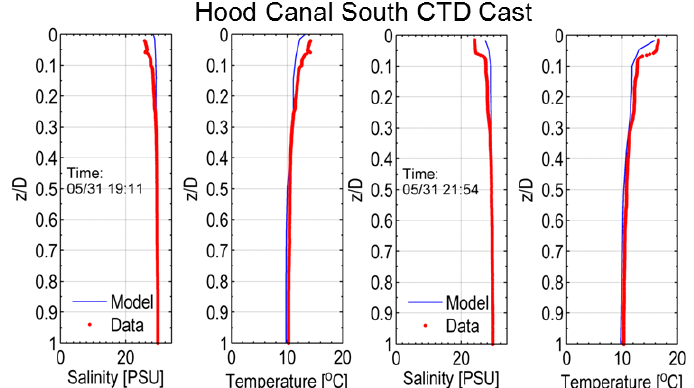
Figure 9. Comparisons of predicted and observed salinities at peak ebb and peak flood south of HCB on 31 May 2017.